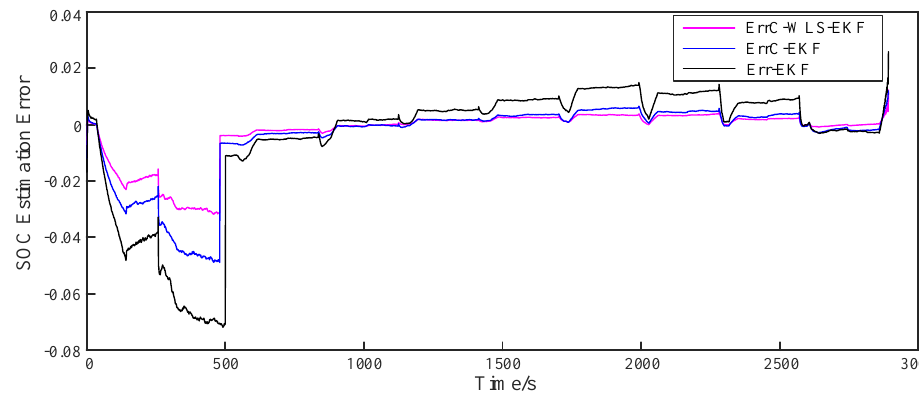
Figure 10. SOC estimation error curve under non-Gaussian noise. Table 7. SOC estimation errors and CPU run time of different methods under non-Gaussian noise conditions.